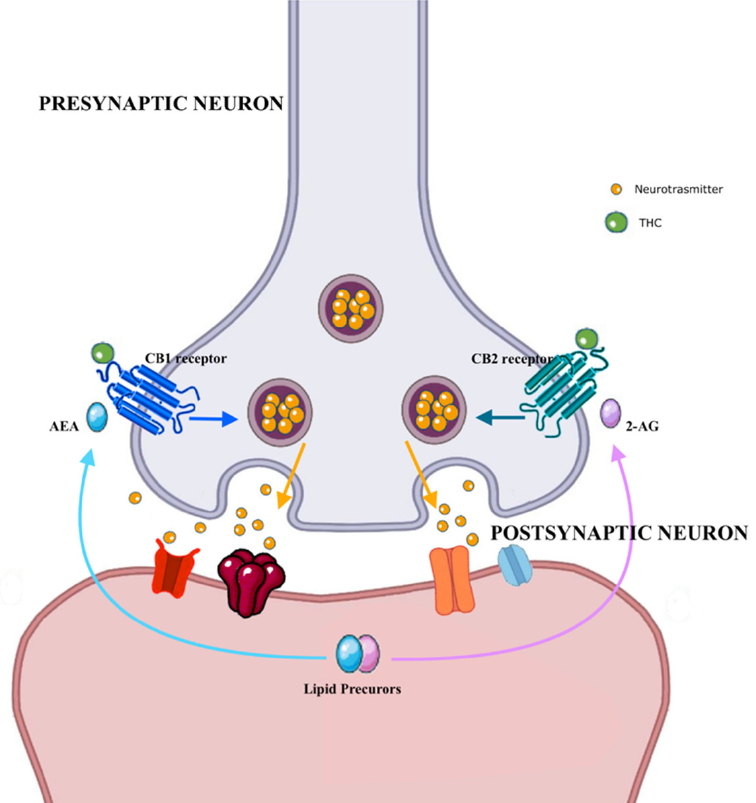
Figure 1. Molecular mechanisms associated with cannabis effects. Abbreviations: AEA: anan- damide, CB1 receptor: cannabinoid 1 receptor, CB2 receptor: cannabinoid 1 receptor, THC: tetra- hydrocannabinol.